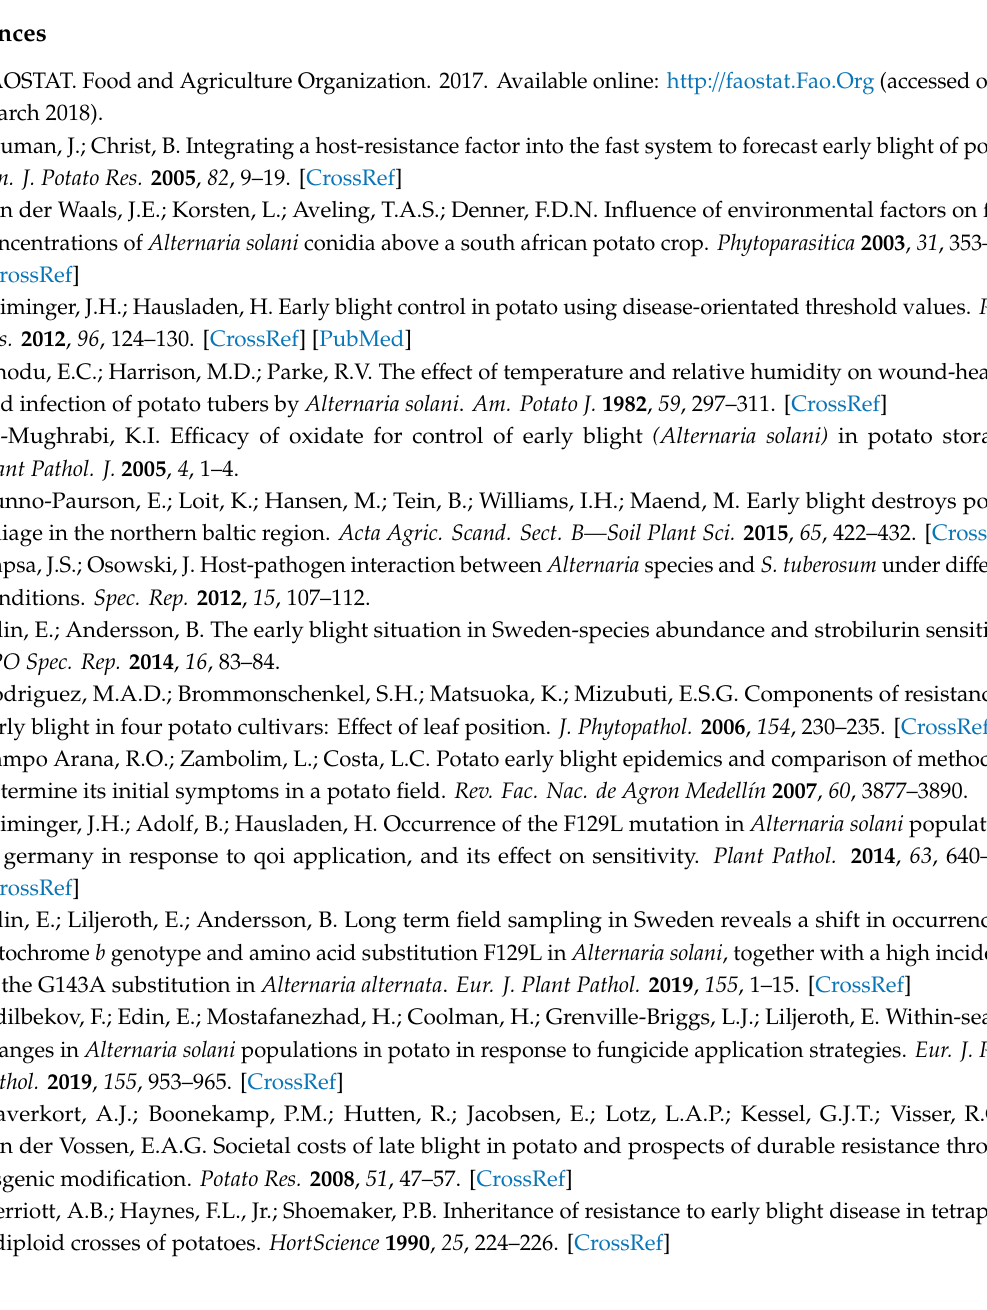
in potato. Table S1: List of significant QTL for foliar resistance to early blight (EB) and defoliation for the years collected separately; Table S2: The genotypes of five o ff spring clones with highest resistance to EB in both foliage (mean over 2014 and 2016) and tuber and their two crossing